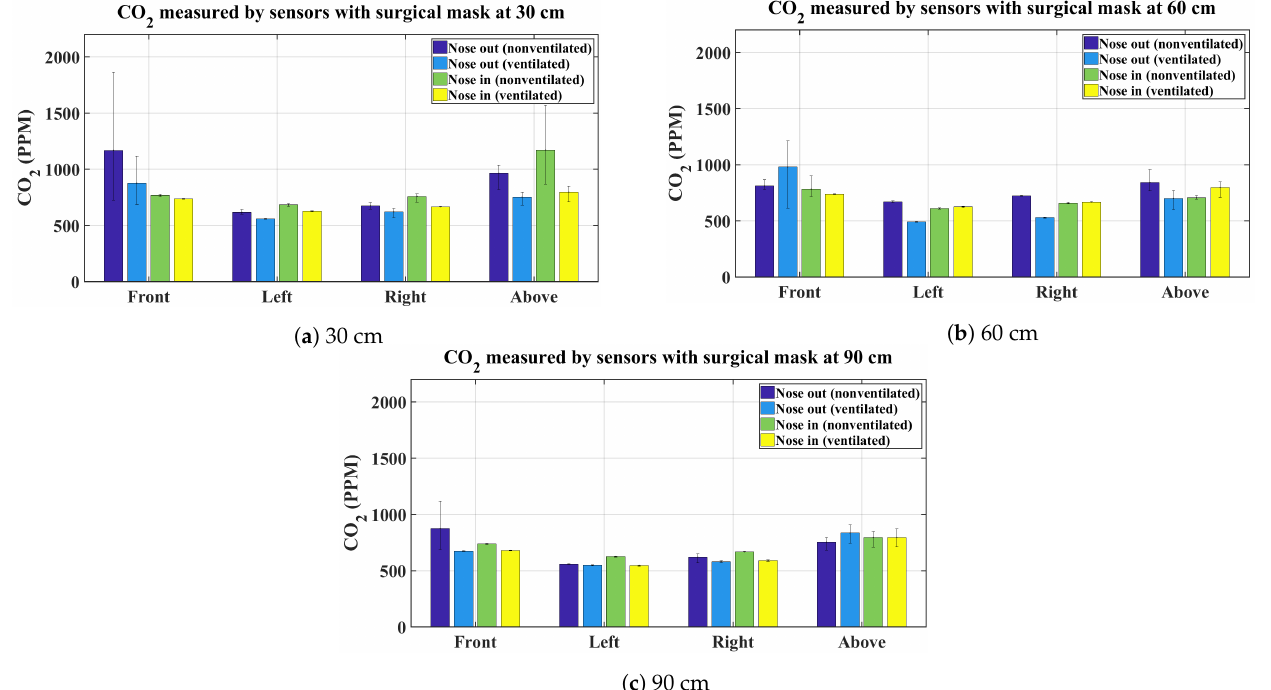
Figure 5. Average CO 2 measurements using a surgical mask.